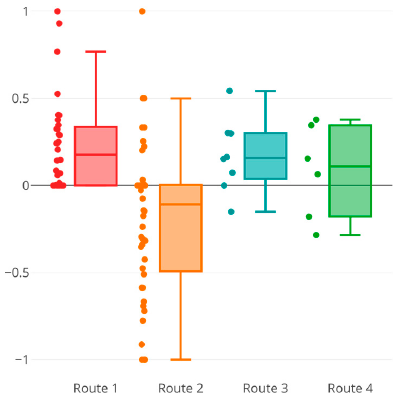
Figure 7. Di ff erence between measured moments of stress and reported stress level